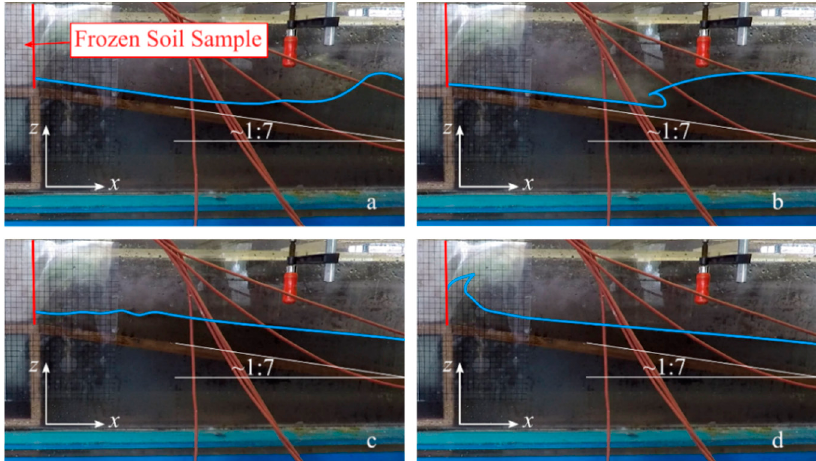
Figure 12. Wave breaking in front of the frozen soil sample at the beginning of Exp. 3. The waves are running up a 1:7 ramp and break as plunging breakers due to shoaling effects. The blue lines mark the development of the wave crest. Panels ( a )–( d ) illustrate the time-history of the surface elevation of the water level in front of the frozen soil sample in a side view.